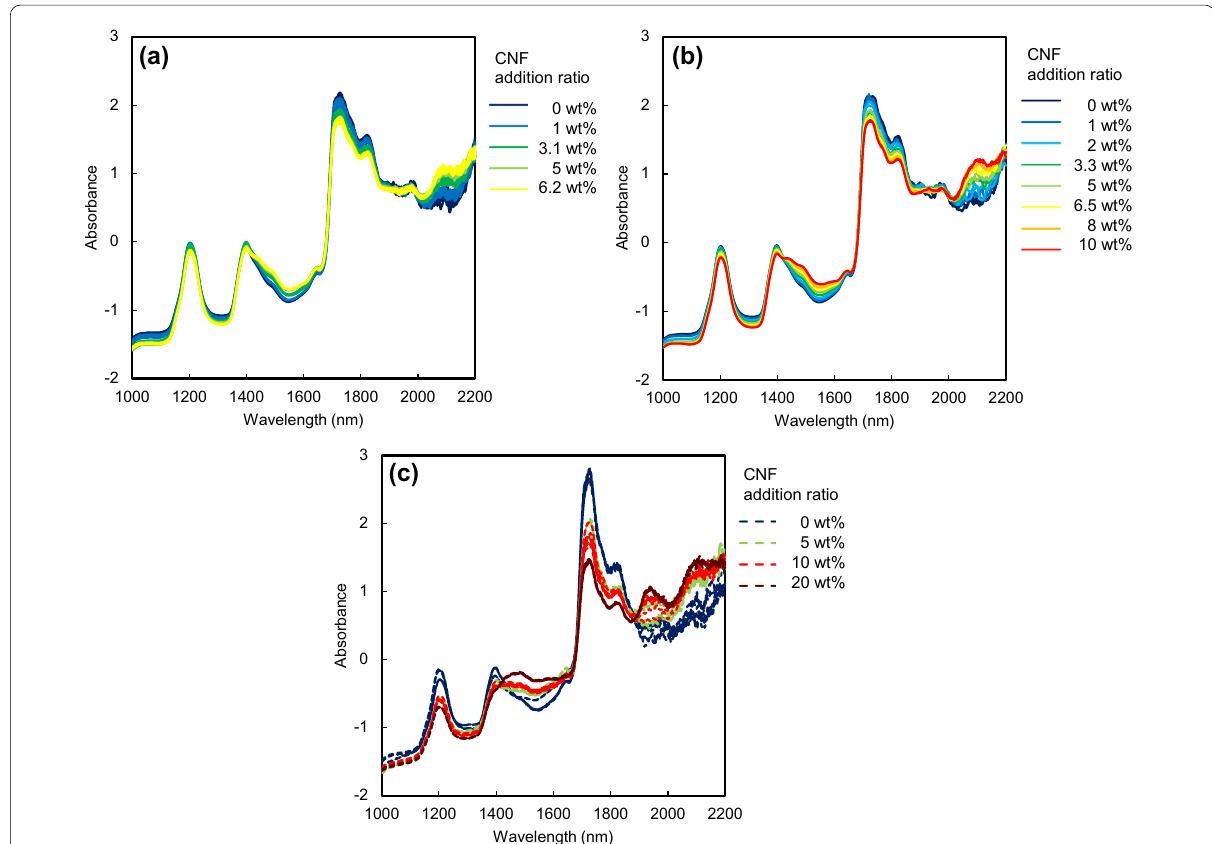
Fig. 2 The NIR spectra of each calibration set of CNF/PP composites after standard normal variate (SNV): a Injection-A, b Injection-B, c Film-A. The details of sample conditions are shown in Table 1